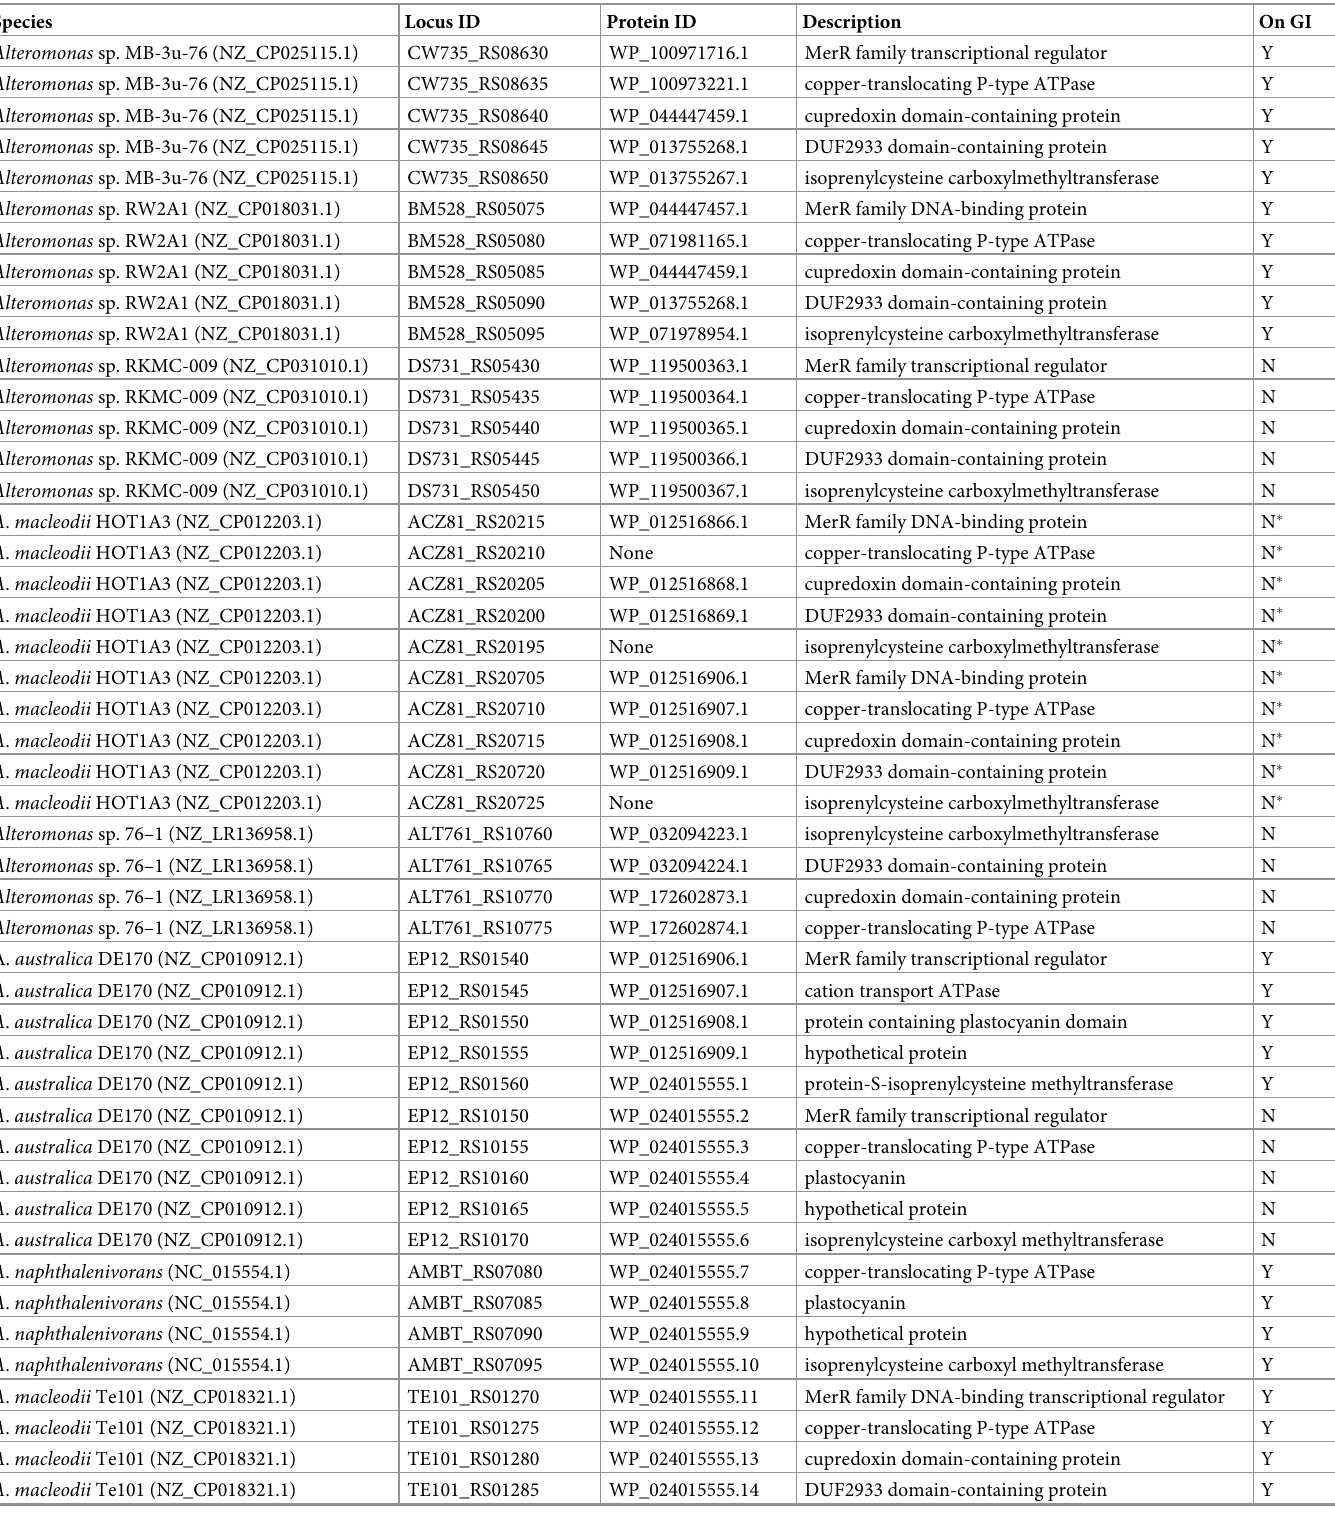
Table 4. Presence and genome organization of merR-copA clusters in Alteromonas